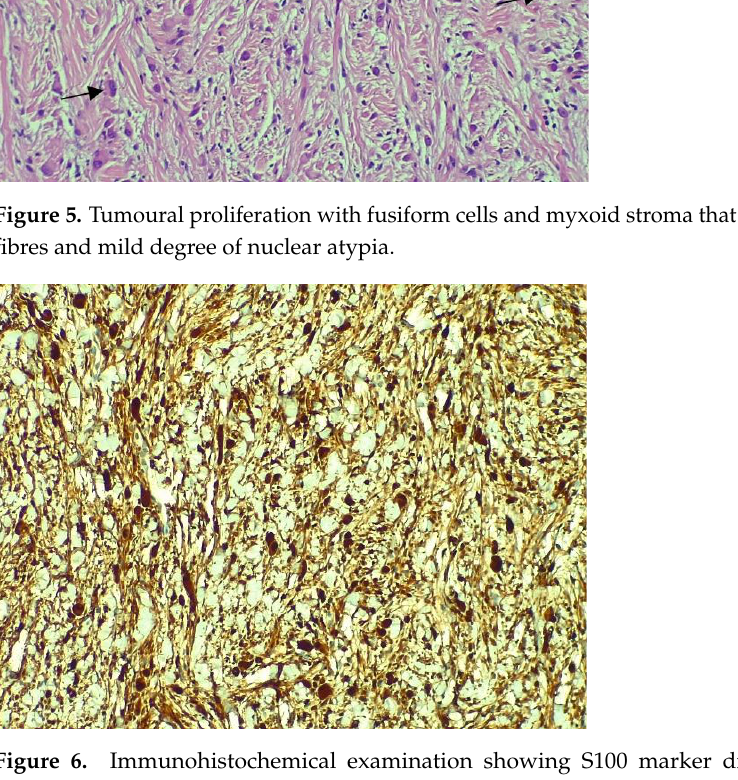
Figure 7. Immunohistochemical examination showing CD34 marker positive in the vessels and the fusiform cells . The patient was discharged 7 days after surgery. Discharge echocardiography showed no notable changes in the left and right ventricular functions, an LVEF of 60%, and mild mitral and tricuspid regurgitations. 3. Discussions MPNST is a rare type of soft tissue sarcoma. It primarily affects the extremities, but it can also rarely originate from the heart. Most of the MPNSTs that affect the heart occur on the right side, close to the interatrial septum. The reason for this location might be the origin of the MPNST from the cardiac branches of the vagus nerve [8 – 11]. A few cases have been reported on the left side of the heart. About 50% of these tumours arise de novo, the other half arise from neurofibromas in the context of type 1 neurofibromatosis [9 – 19]. Patients with neurofibromatosis type I have an 8 – 13% greater risk of developing an MPNST than the general population [19,20]. Our patient had no features of neurofibromatosis type I. She had no cardiovascular symptoms, her intracardiac tumour being fortunately diagnosed after a routine TTE. Echocardiography is a fast, non-invasive, low-cost imaging tool that provides the first idea of the tumour’s aetiology and is able to obtain information about the location, mobility, appearance and attachment of the tumour that can help determine if the mass is benign or malignant. Most of the time, TTE is performed for another indication and may be the first imaging tool that determines the